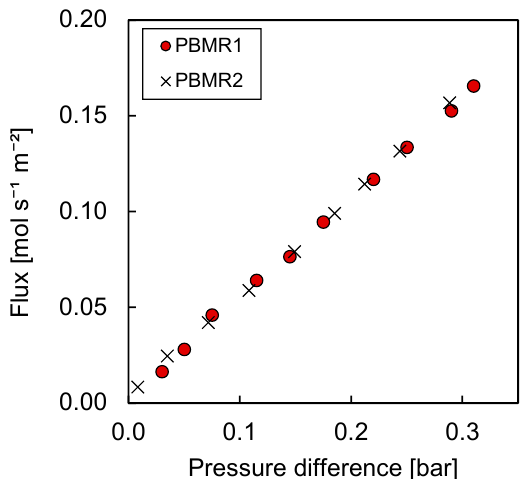
Figure 6. Flux of the symmetric MgO porous membrane plotted against the retentate–permeate pressure difference.